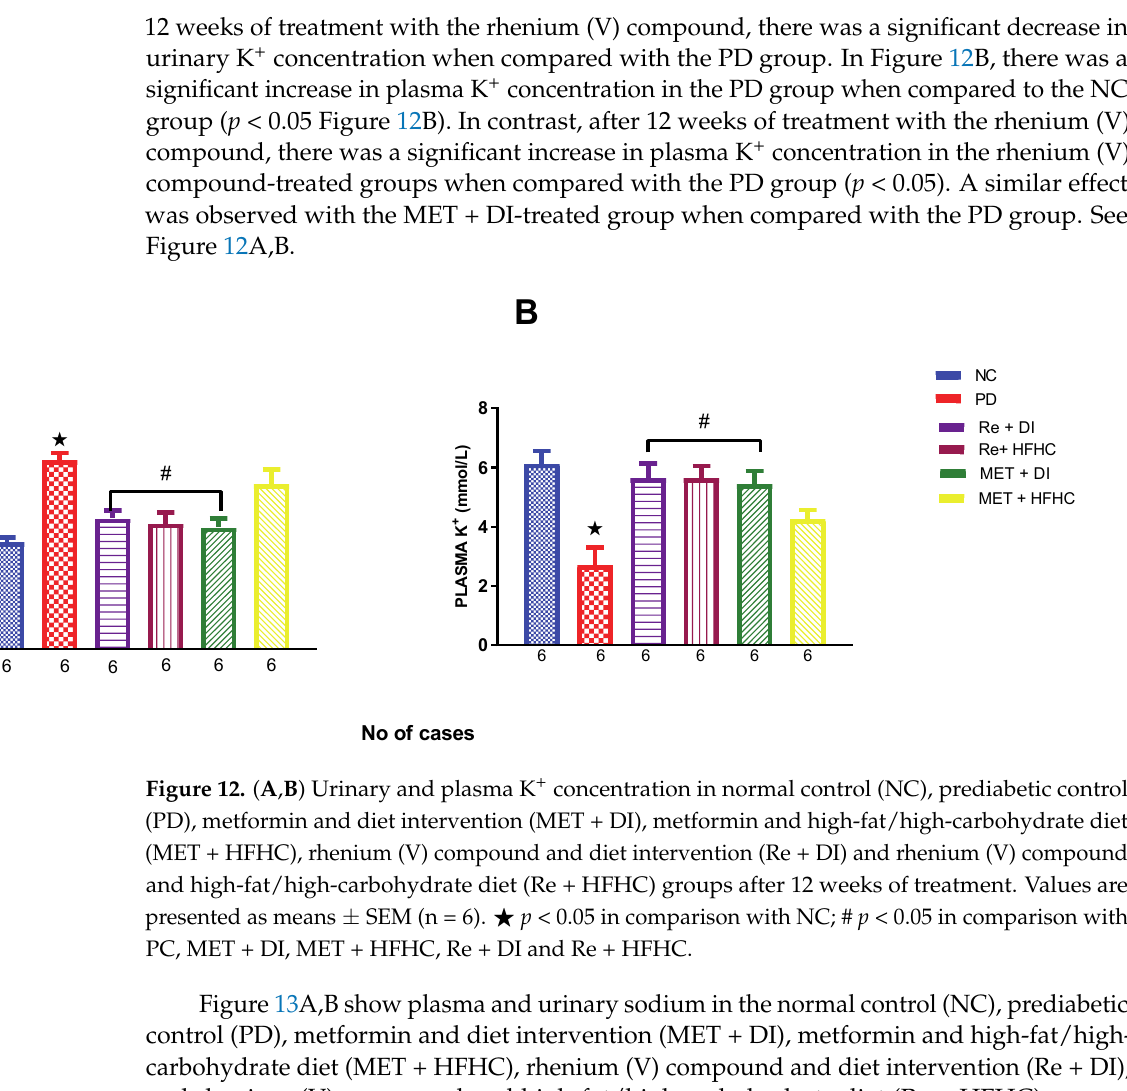
PC, MET + DI, MET + HFHC, Re + DI and Re +